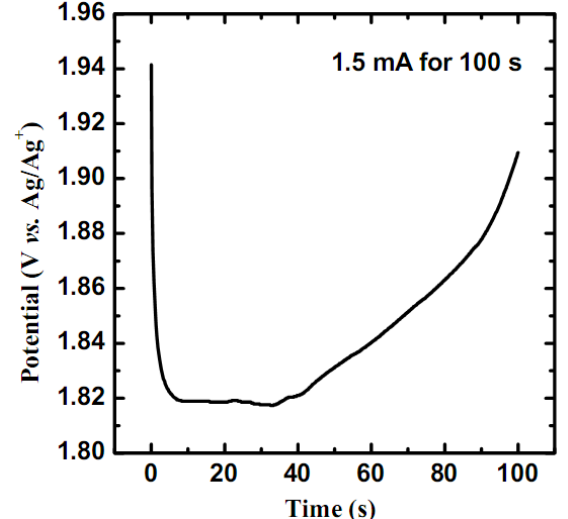
Figure 2. The chronopotentiometry of the poly(3-TPAA) film electroploymerized at a constant current of 1.5 mA for 100 s in an organic electrolyte.